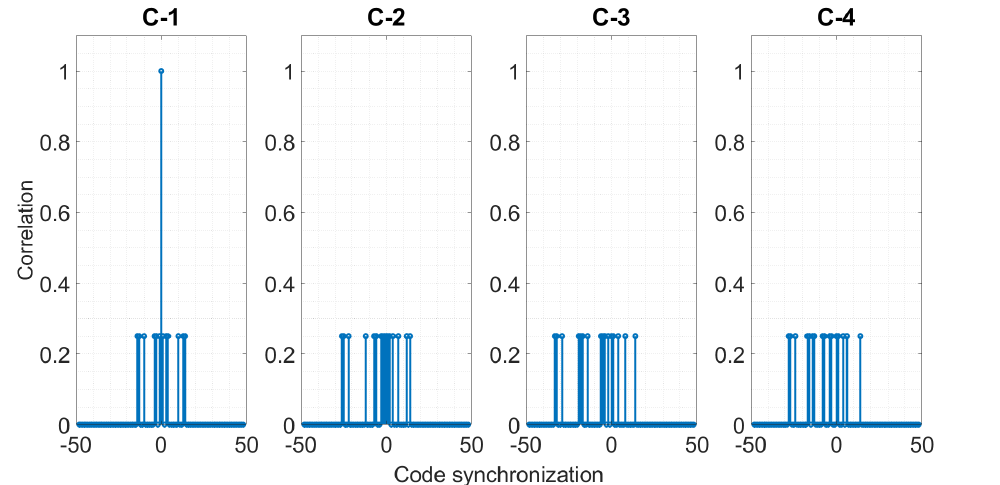
Figure 13. Correlation of OOC code 1 with the rest of the OOC codes. OOC code 1 was selected as the code for the intended transmitter-receiver pair for the simulation results in Figure